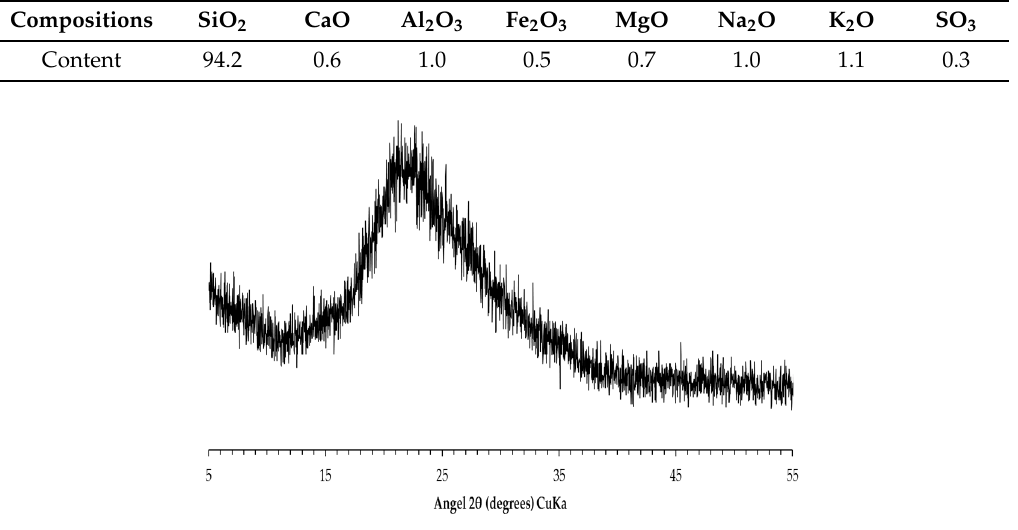
Figure 3. XRD pattern of silica fume used in this study.